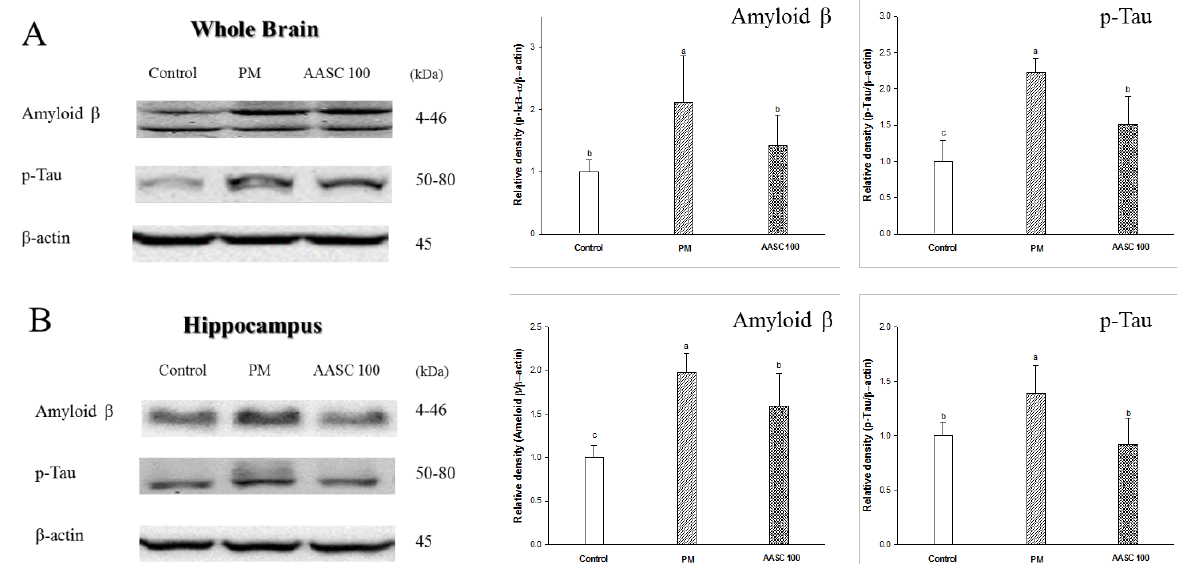
Figure 6. The effect of AASC on amyloid beta and phosphorylated Tau in the brains of mice exposed to PM 2.5 . ( A ) Whole brain and ( B ) olfactory bulb. Results are indicated as mean ± SD ( n = 8). Different small letters represent the statistical difference ( p < 0.05) of each group in a high order.